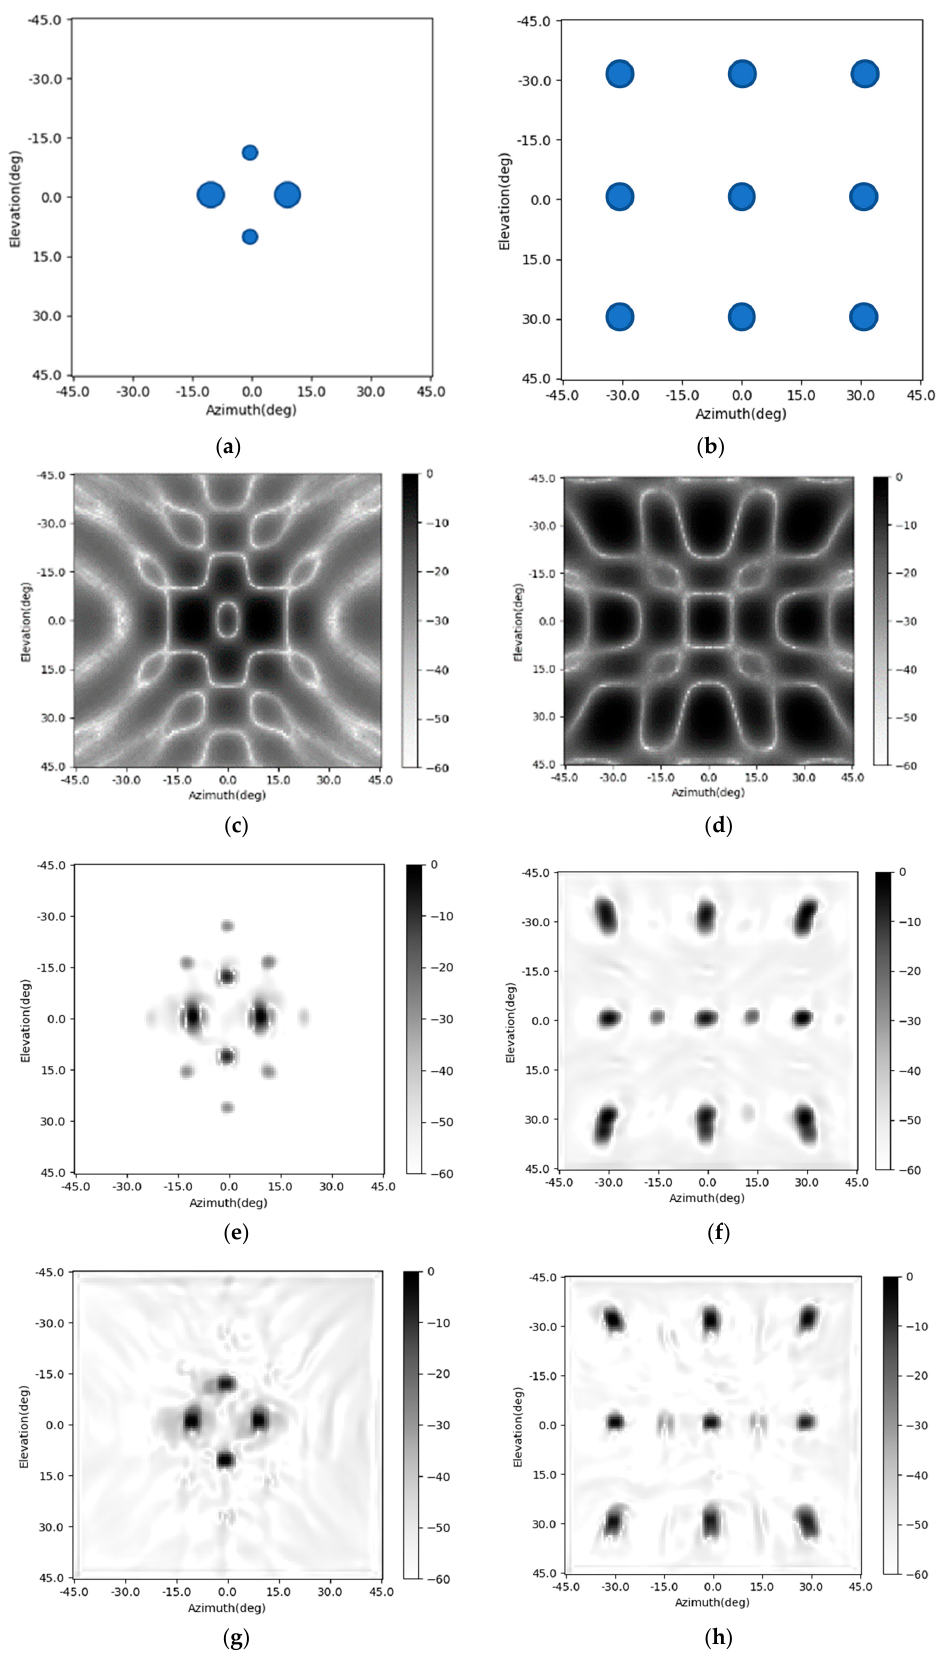
Figure 6. Enhancing result of the CNN and the SV-CNN ( a , b ) imaging scenes; ( c , d ) original radar images; ( e , f ) enhancing results of the CNN; ( g , h ) enhancing result of the SV-CNN.